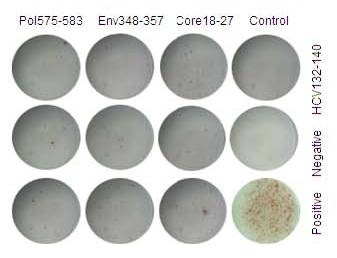
ELISPOT results from CHB patients. Sequence of Pol575-58 is FLLSLGIHL, sequence of Env348-357 is GLSPTVWLSV, sequence of Core18-27 is FLPSDFFPSV, sequence of HCV Core132-140 is DLMGYIPLV; all are HLA-A0201 limited. Medium without stimulation or cells was used for negative control, PHA for positive control. 2 × 10E5 cells per well was used for the negative and peptide stimulated groups, 1 × 10E4 cells per well was used for the positive control. The final concentration of peptide was 10 μg/ml, PHA 4 μg/ml. HLA-A0201 positive patients were chosen as the research subjects.